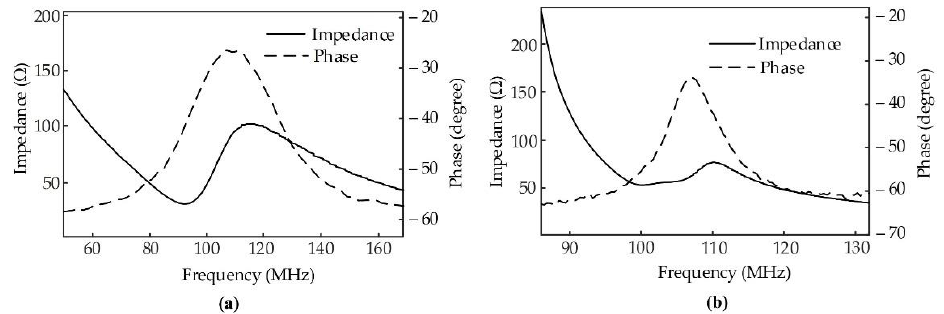
Figure 5. Measured electrical impedance magnitude (solid line) and phase angle (dashed line) ( a ) 103 MHz PMN-0.3PT transducer and ( b ) 105 MHz LiNbO 3 transducer.